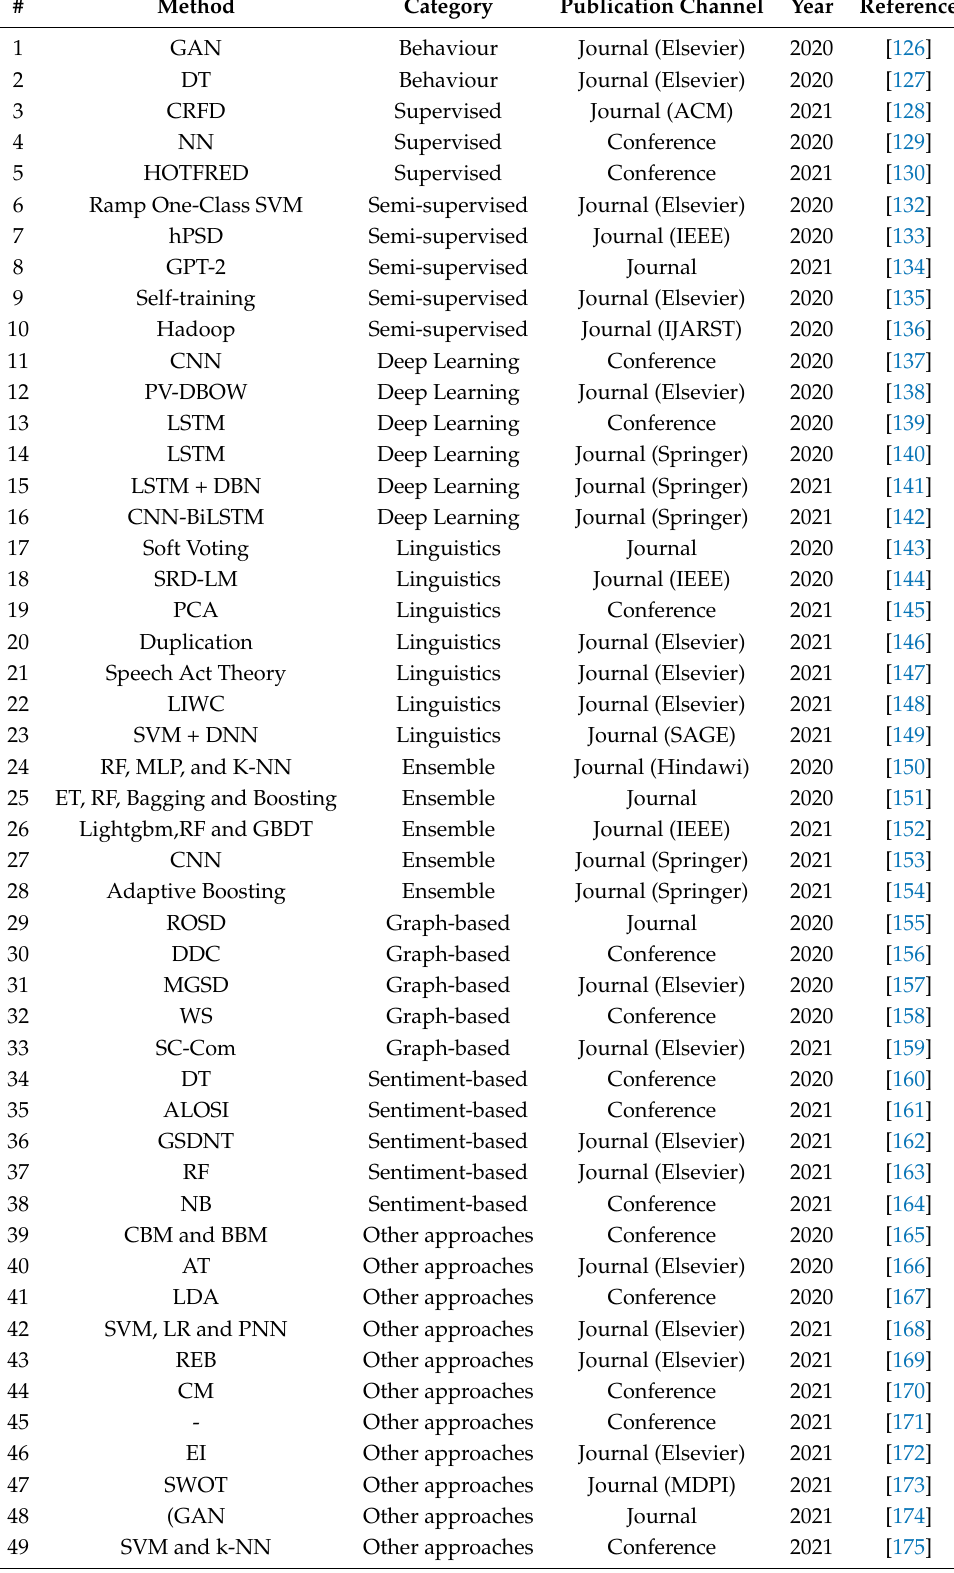
Table 3. Detailed information of spam reviews detection